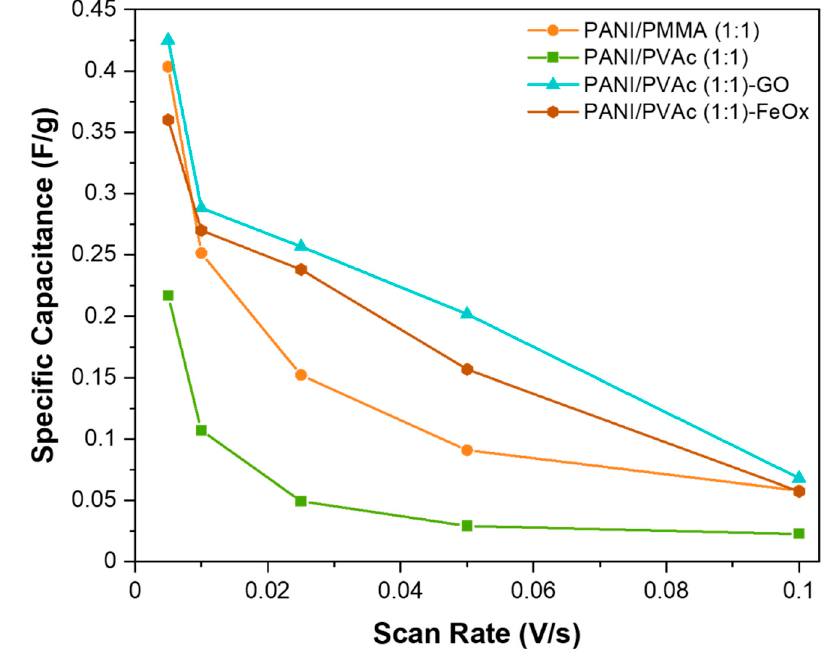
Figure 5. Specific capacitances of electrospun blended mats .